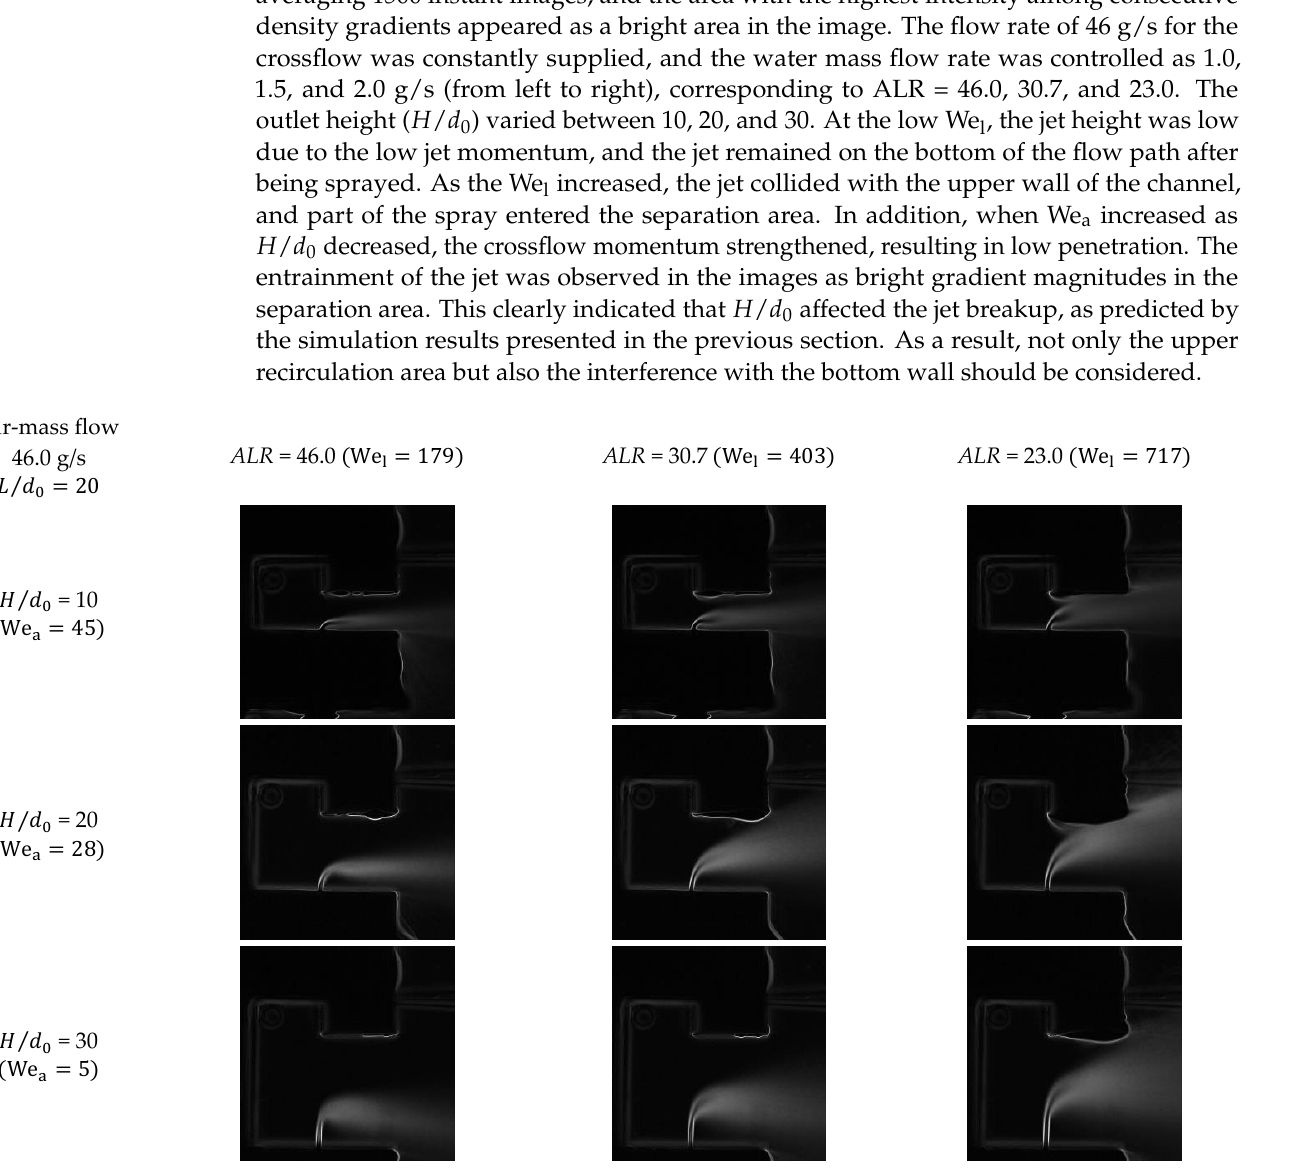
Figure 9. Density gradient magnitude images at various flow conditions in three types of geometries.